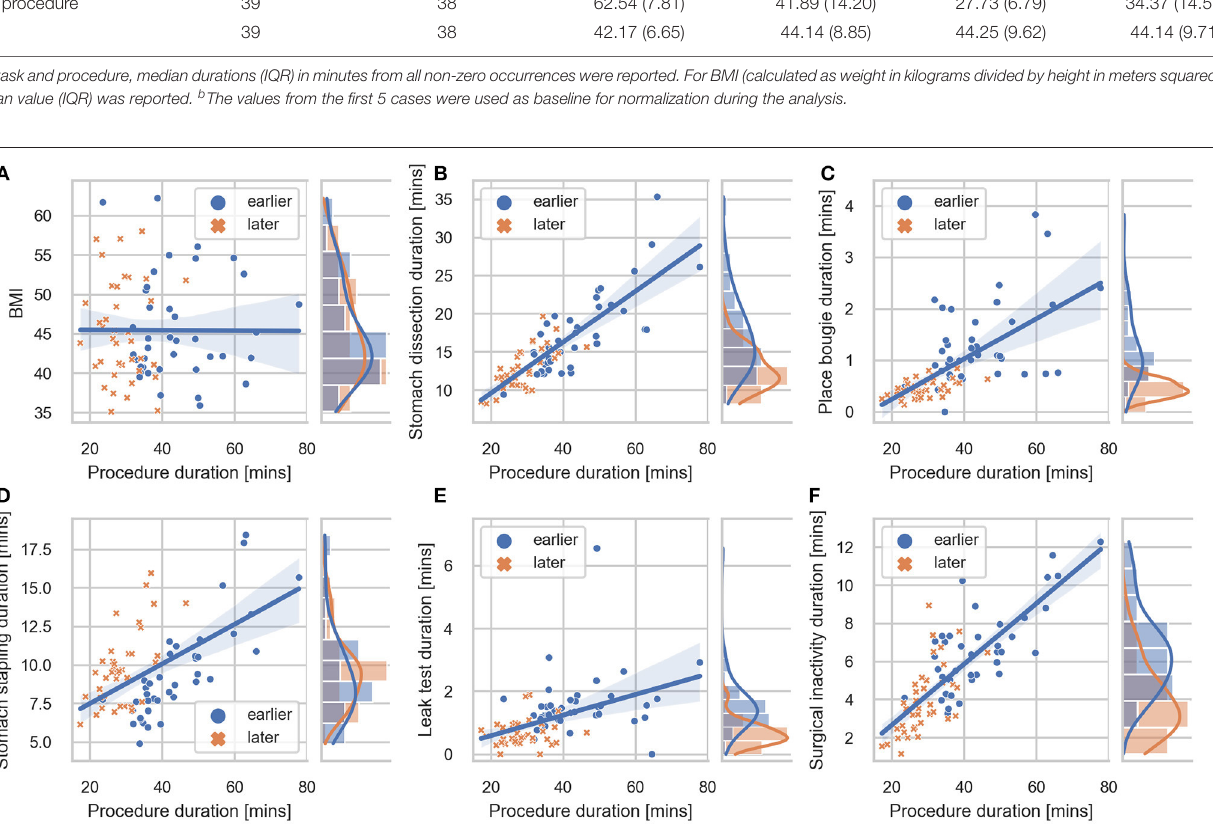
FIGURE 3 | Correlation plot between BMI, task durations and procedure duration. Regression lines are included for each sub-comparison. The 95% confidence intervals were shown as the translucent bands around the regression line. Distributions of (A) BMI, (B) stomach dissection, (C) place bougie, (D) stomach stapling,